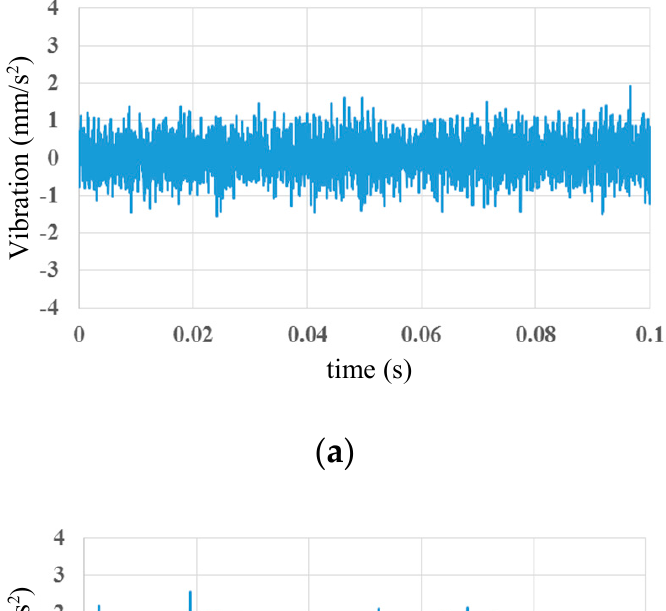
Figure 5. Block diagram for a PMSM under a vector control strategy.